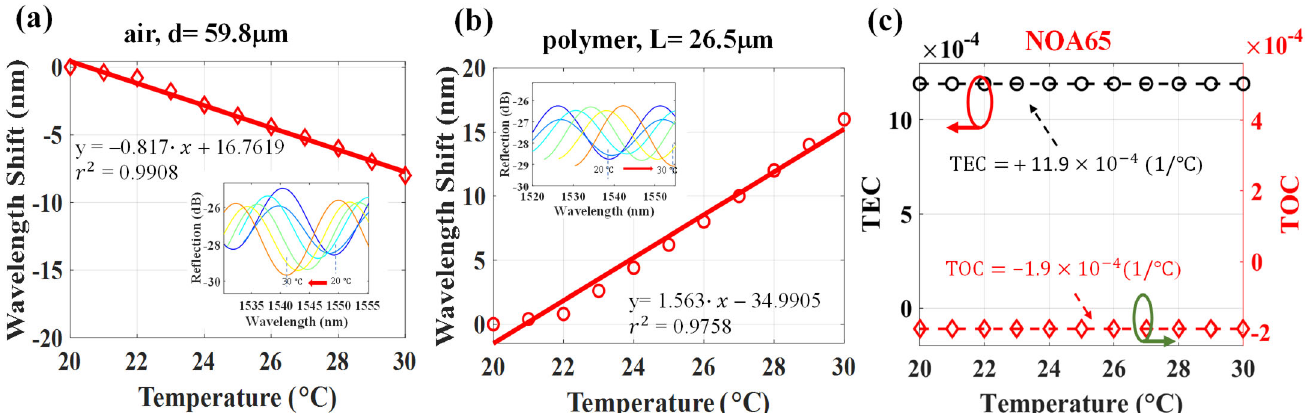
Figure 6. Wavelength shifts from 20 °C to 30 °C for the cavities of ( a ) air, ∆λ a , and ( b ) NOA65-polymer, ∆λ p ; ( c ) measured TEC and TOC from the results of ( a , b ).